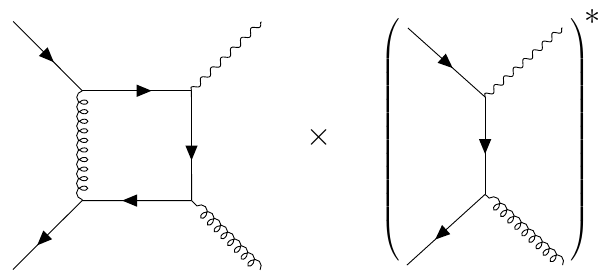
Figure 5 . NNLO contribution to q ¯ q → γ ∗ from interference of box and tree-level amplitudes. There are three different boxes and two different tree-level diagrams for this